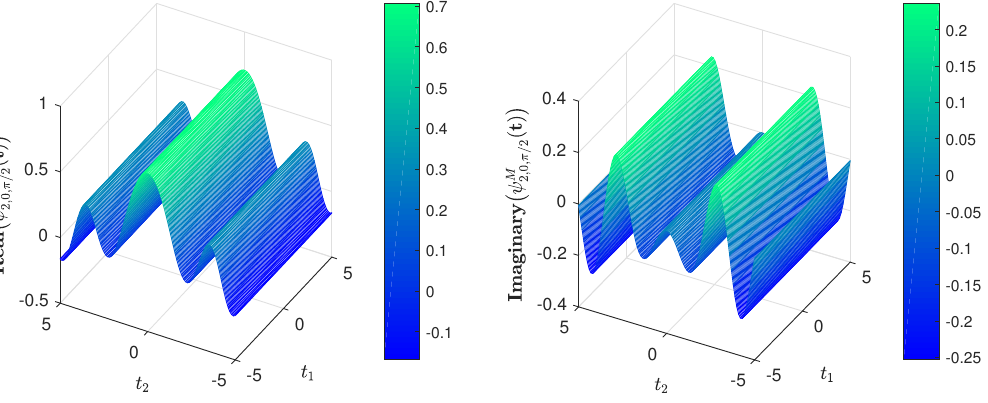
Figure 1. The linear canonical ridgelet waveforms for M = ( 1,2;1/2,2 ) at scale a = 2, location b = 0, and orientation θ = π /2.